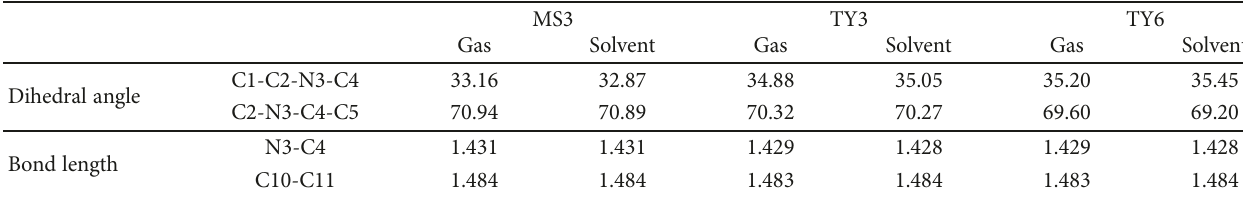
Table 1: Selected bond lengths ( Å ) and dihedral angles ( ° ) of MS3, TY3, and TY6.